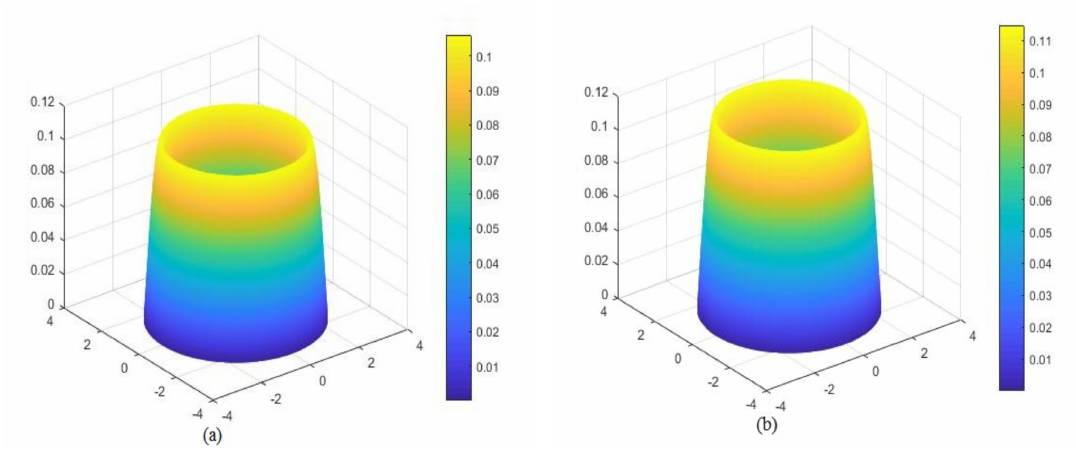
Figure 3. ( a ) The NBE solution u k at t = 0.4. ( b ) The analytical solution u k